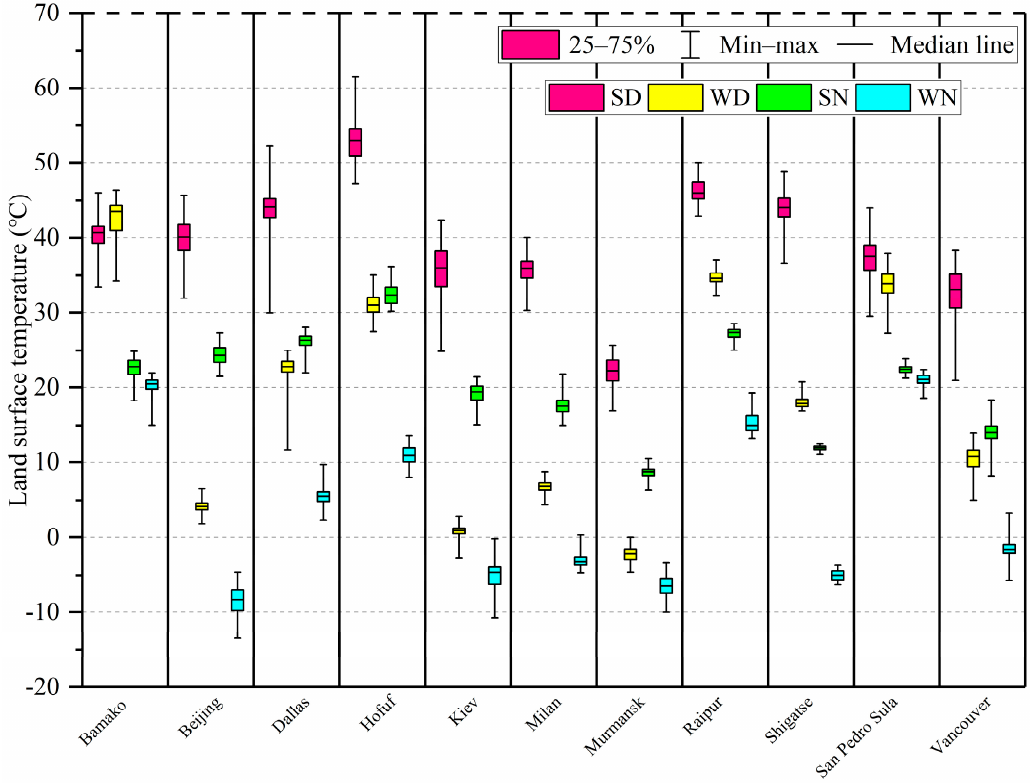
Figure 1. Box figure for the land surface temperatures during the daytime and nighttime in the summer and winter in the eleven selected cities in different global climatic zones. SD, WD, SN and WN refer to the summer daytime, winter daytime, summer nighttime and winter nighttime, respectively. LSTs’ standard deviations (SDs) showed different diurnal and seasonal variations in